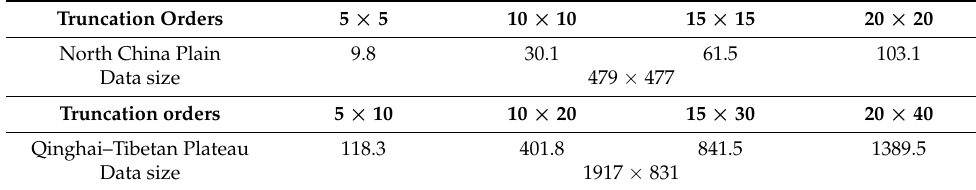
Table 6. The different truncation order times. Unit: